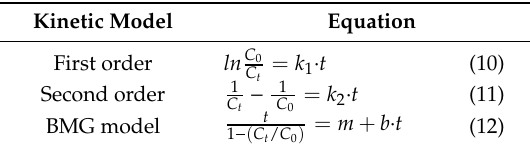
Table 1. Linear form of the kinetic models.